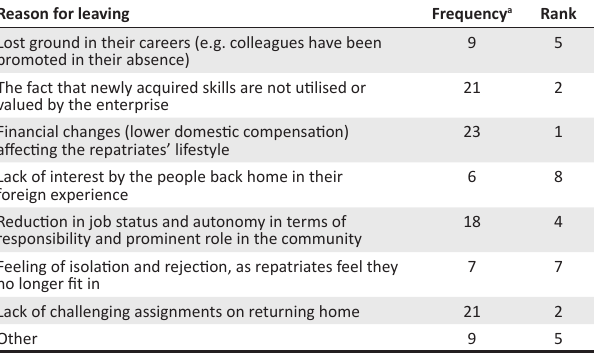
TABLE 14: Reasons why expatriates leave after repatriation.